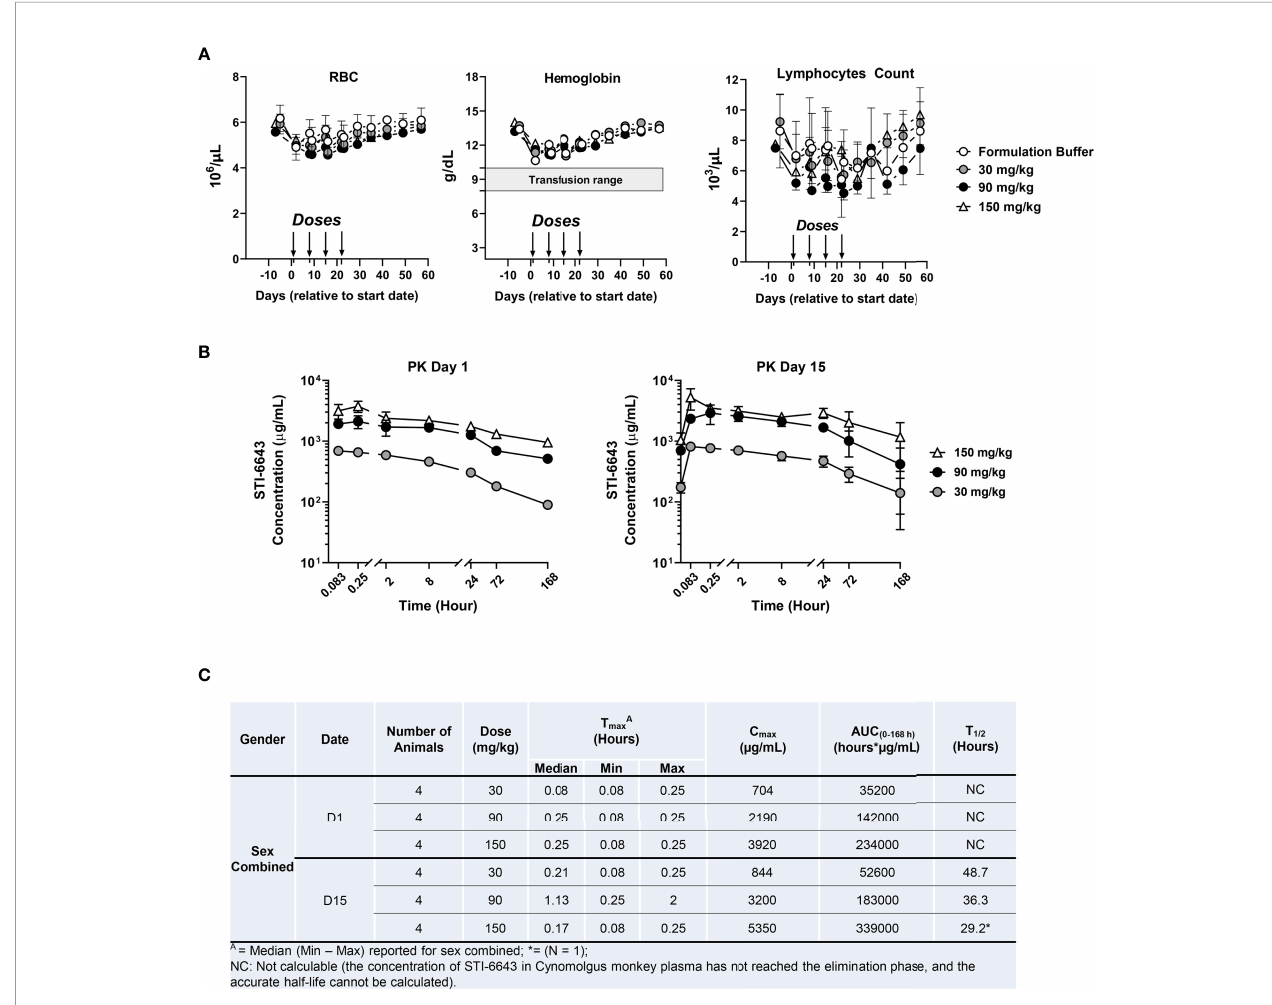
FIGURE 3 | STI-6643 demonstrates high safety pro fi le in non-human primate toxicokinetic study. Individual cynomolgus monkeys were administered intravenously on days 0, 7, 14 and 21 with STI-6643 at the indicated doses or the same volume of formulation buffer (marked by arrows). The hematological parameters of individual monkeys were monitored for 9 weeks. (A) The hemoglobin levels, the RBC and lymphocytes counts were measured overtime. The shaded bar indicates the range of hemoglobin that might trigger transfusion in humans. (B) Serum STI-6643 levels were determined after a single infusion (PK day 1) or after the third infusion (PK day 15) at the indicated doses. (C) Pharmacokinetic parameters in cynomolgus monkeys dosed in panel (B) T max : time of C max , C max : maximum observed concentration, AUC (0-168h) : area under the curve and T 1/2 : half-life. Data are given as a mean ±